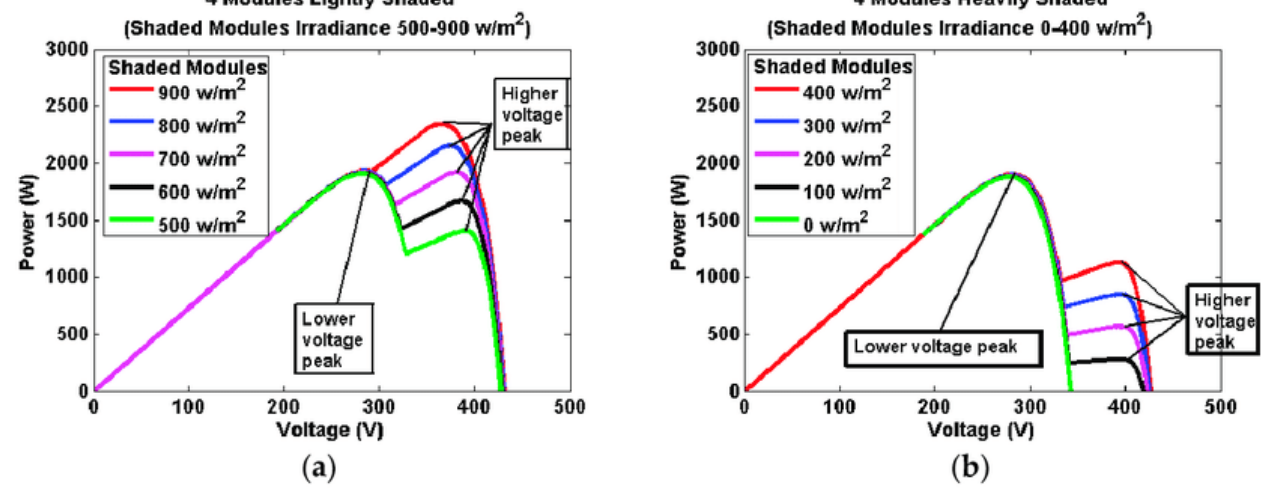
Fig. 2. Characteristic curves of four shaded photovoltaic modules [7]